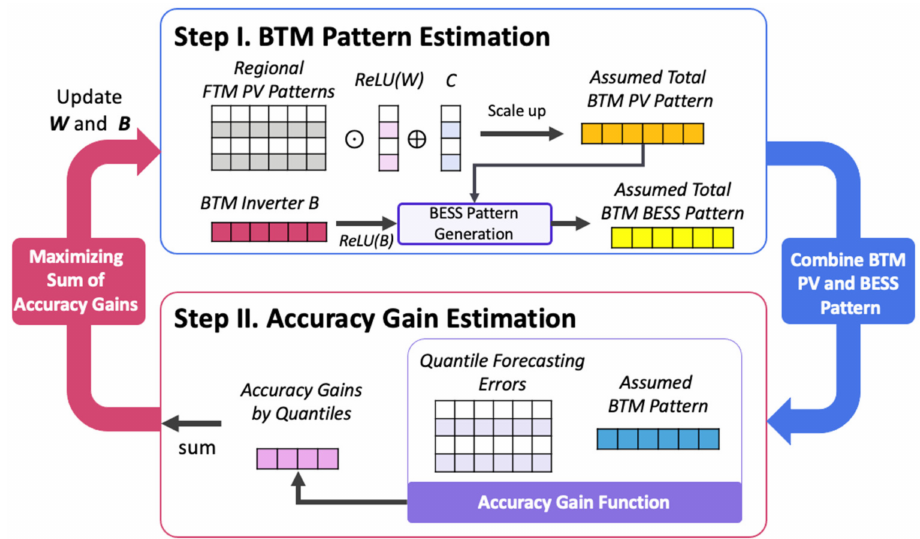
Figure 8. Illustrated BTM estimation method using joint optimization.